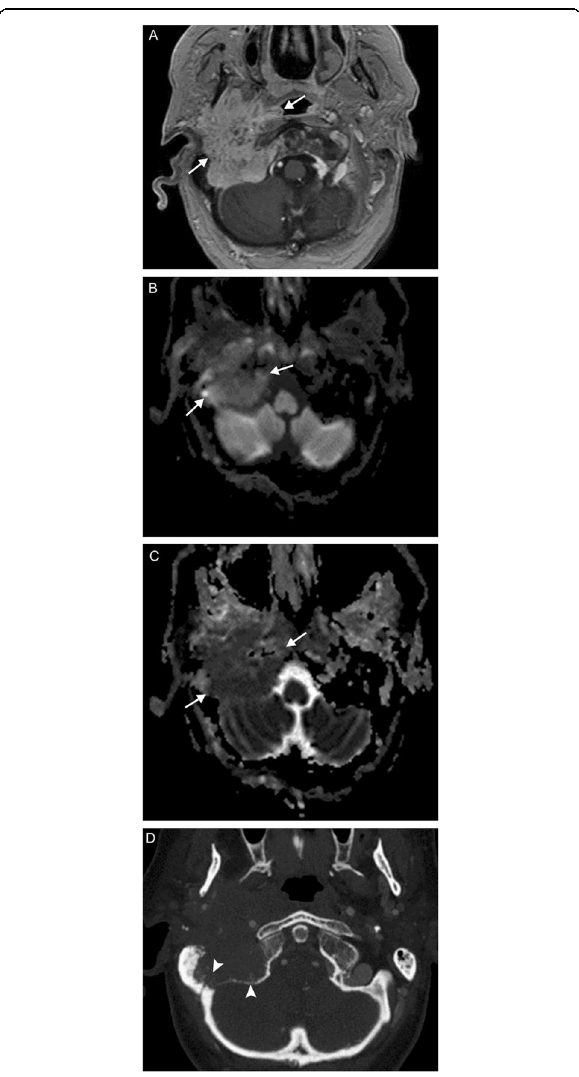
Fig. 17 Vagal Schwannoma. A 53-year-old man with months of cough and hoarseness, thought to be reflux but not improved with proton pump inhibitor. Axial T2 ( a ), axial post-contrast T1 ( b , c ), and coronal post-contrast T1 ( d ) MR images reveal a well-circumscribed enhancing mass (arrows) with cystic components extending through the right jugular foramen (note the 'waist') into the carotid space. The right internal jugular vein (arrowheads) is compressed within the carotid sheath. Findings are characteristic for a